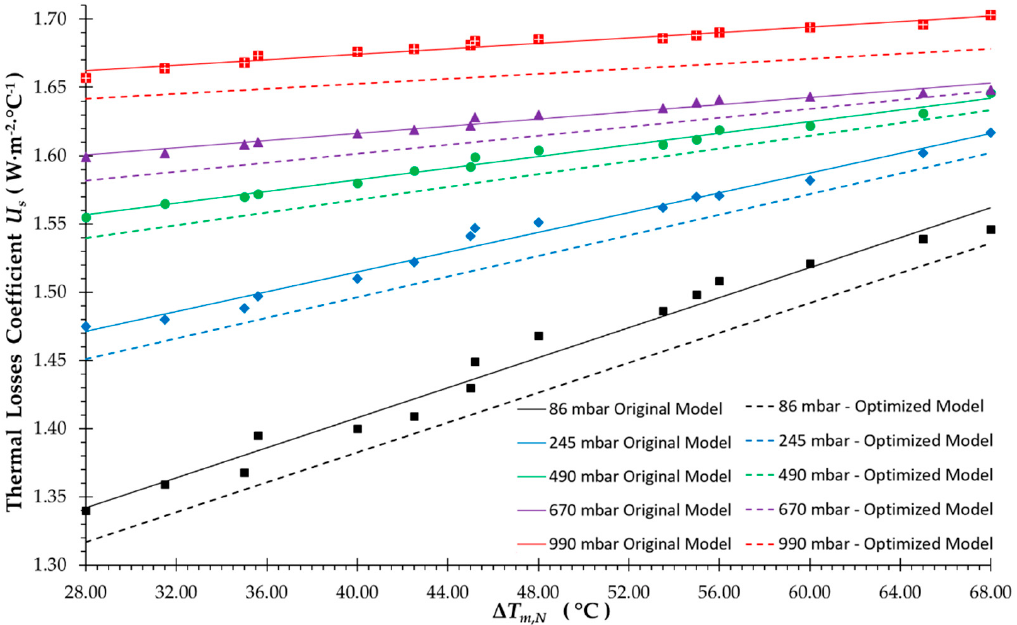
Figure 10. Variation of the thermal loss coefficient for the optimized and reference ICS models.